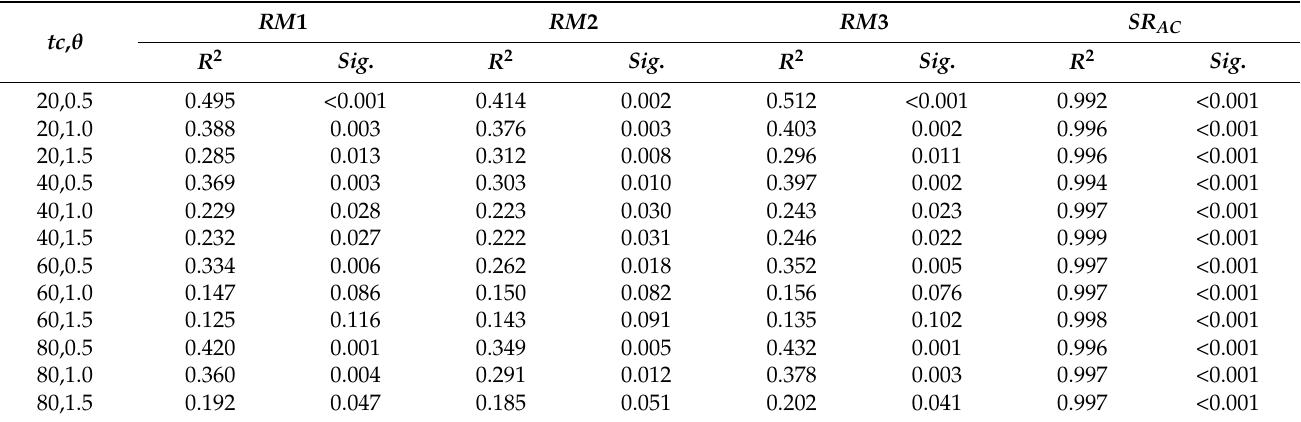
Table 3. Solution robustness correlation analysis.